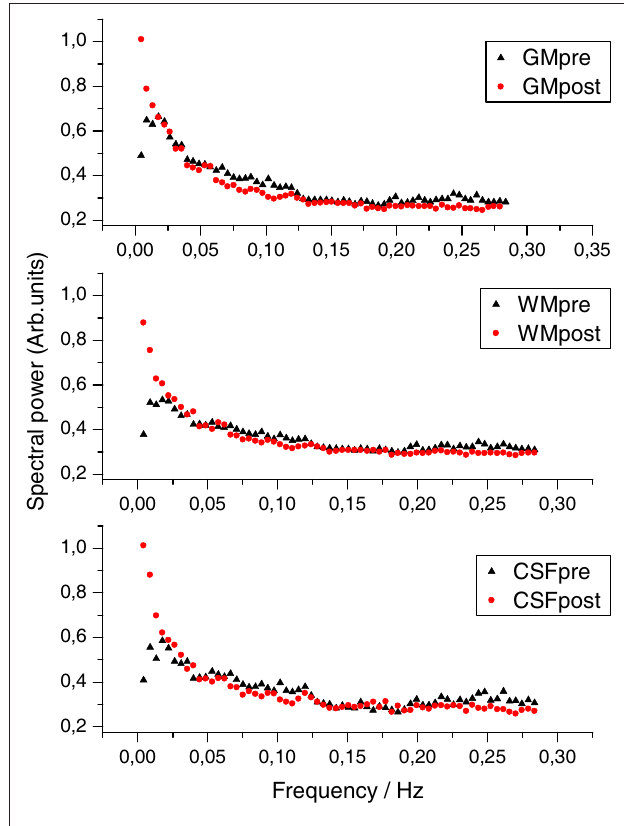
FIGURE 1 | The grey (GM), white (WM) and cerebrospinal fl uid (CSF) mean power spectral before (pre in black) and after (post in red) hyperventilation, showing the elevation of the power at the lowest frequencies and the altered PSD confi guration after